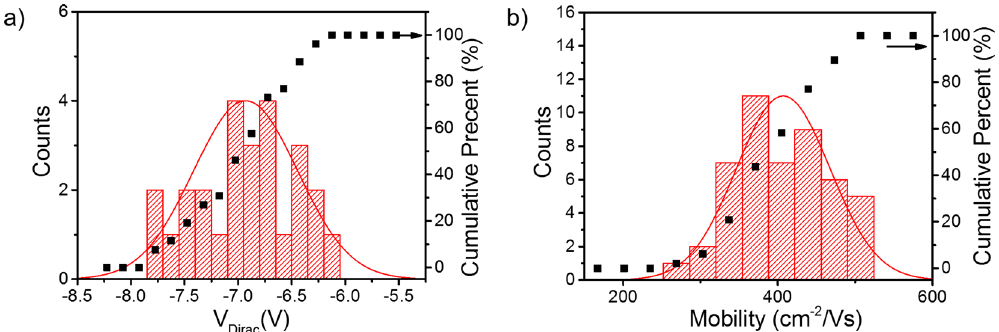
Figure 6. Histogram and cumulative percent plots of extracted ( a ) Dirac voltage and mobility from 50 devices with channel length between 2 and 10 µ m on smooth